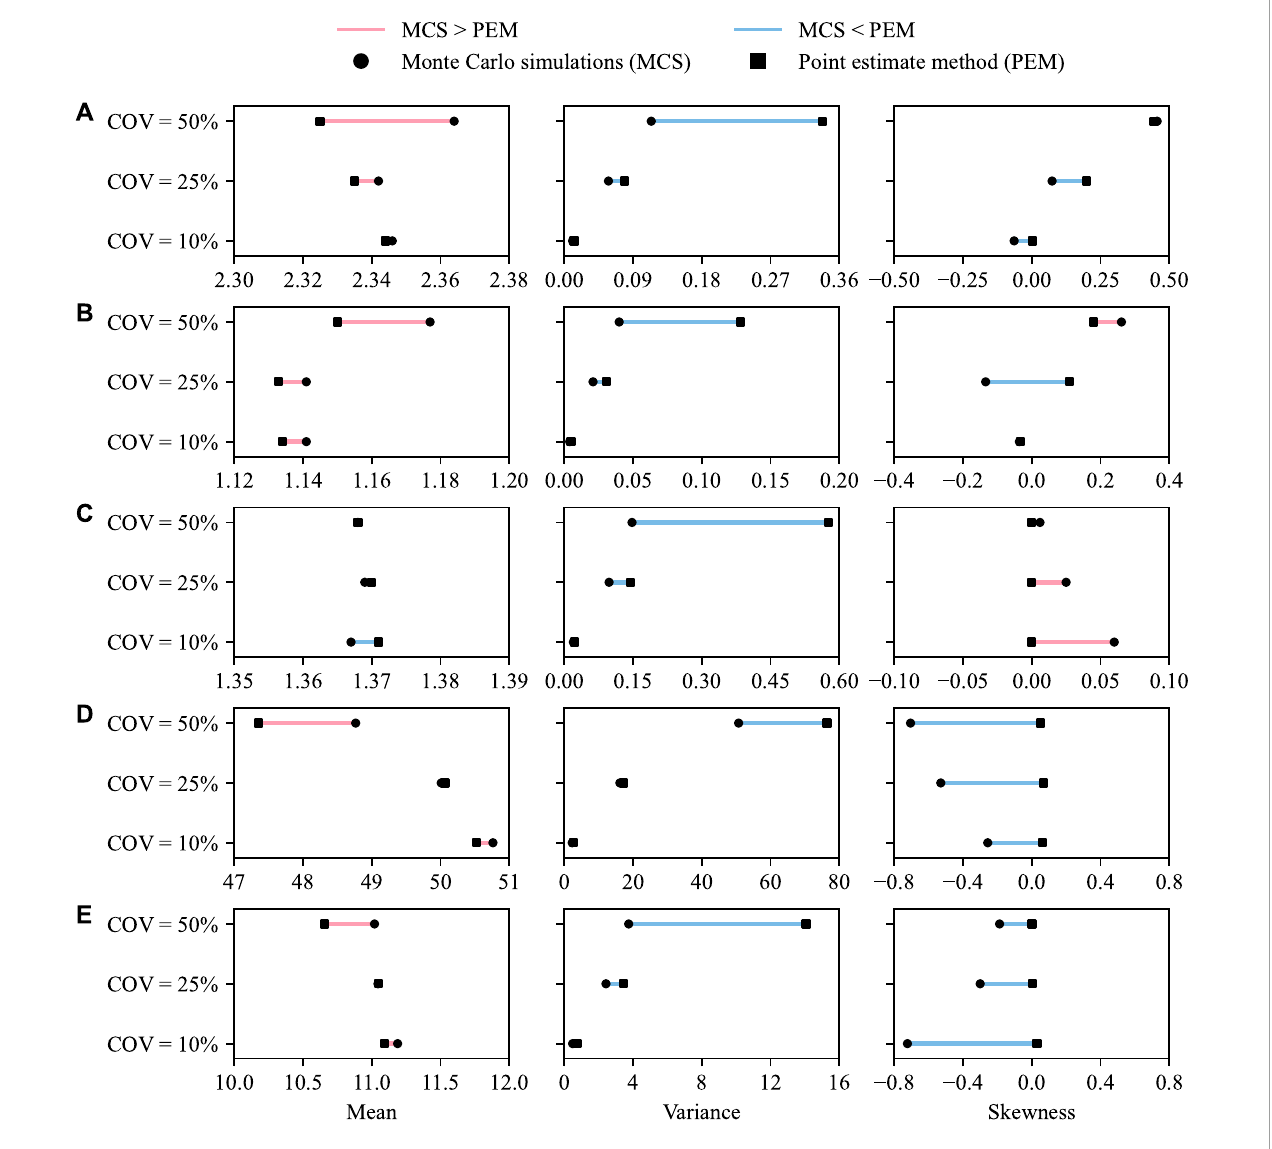
FIGURE 3 Three moments (mean, variance and skewness) of (A) impact area (in x10 6 m 2 ), (B) deposit area (in x10 6 m 2 ), (C) deposit volume (in x10 6 m 3 ), (D) maximum flow velocity (in m/s) and (E) maximum flow height (in m) at ( x , y ) = (1000, 2000) obtained from synthetic case with Monte Carlo simulations (MCS) and point estimate method